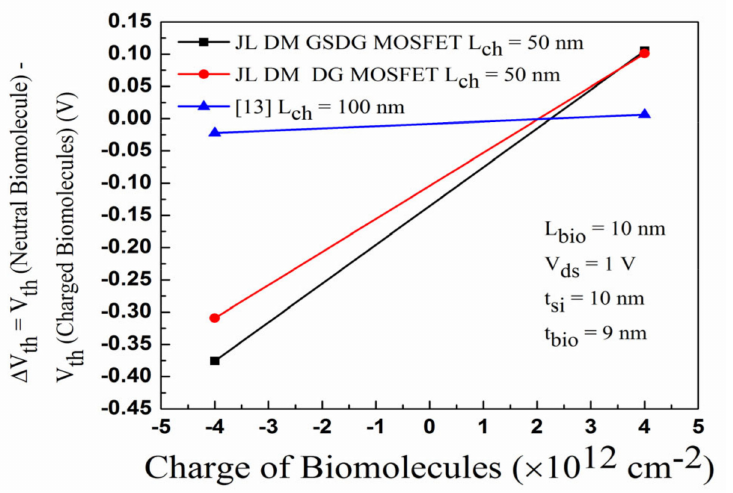
Figure 12. Plot of the sensitivity factor ( ∆ V th ) for JL-DM-DG-MOSFET and JL-DM-GSDG-MOSFET, for charged